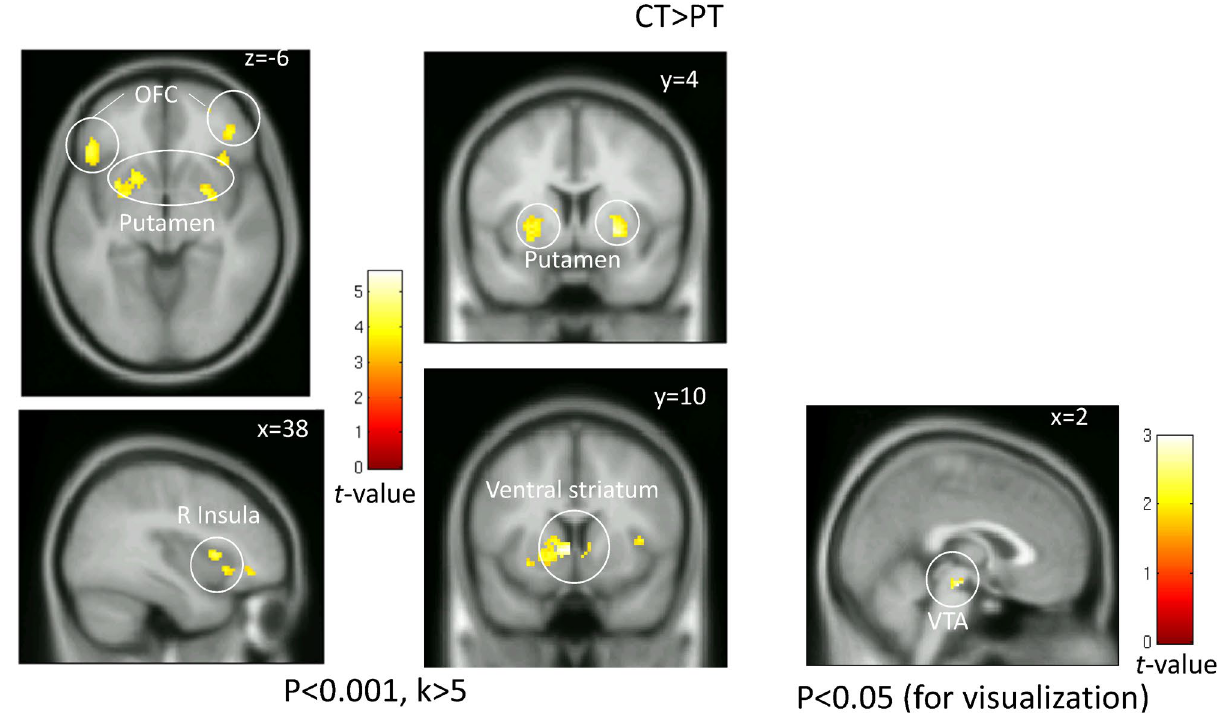
Figure 4. Brain activity in response to the non-conscious presentation of happiness. The map shows a significantly greater activation in response to non-conscious happy face stimuli in the healthy control than the insomnia patient group. Significant differences were observed in the ventral striatum, putamen, orbitofrontal cortex (OFC), right insula, and ventral tegmental area (VTA). Significant clusters are rendered on a T1 anatomical referential image displayed in neurological convention, with the left side corresponding to the left hemisphere. The cluster shown on the VTA were made using a threshold with a lenient alpha level (p < 0.05, k > 5) for visualization purposes.